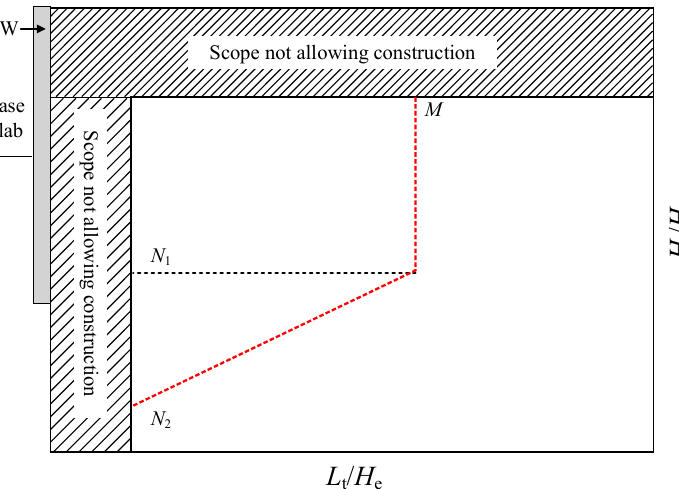
Figure 8. In fl uenced zone of deep excavation on adjacent tunnel displacement ( H e = 9 m): ( a ) δ hm = Figure 8. Influenced zone of deep excavation on adjacent tunnel displacement ( H e = 9 m): 0.18% H e ; ( b ) δ hm = 0.3% H e ; ( c ) δ hm = 0.7% H e . ( a ) δ hm = 0.18% H e ; ( b ) δ hm = 0.3% H e ; ( c ) δ hm = 0.7% H e .